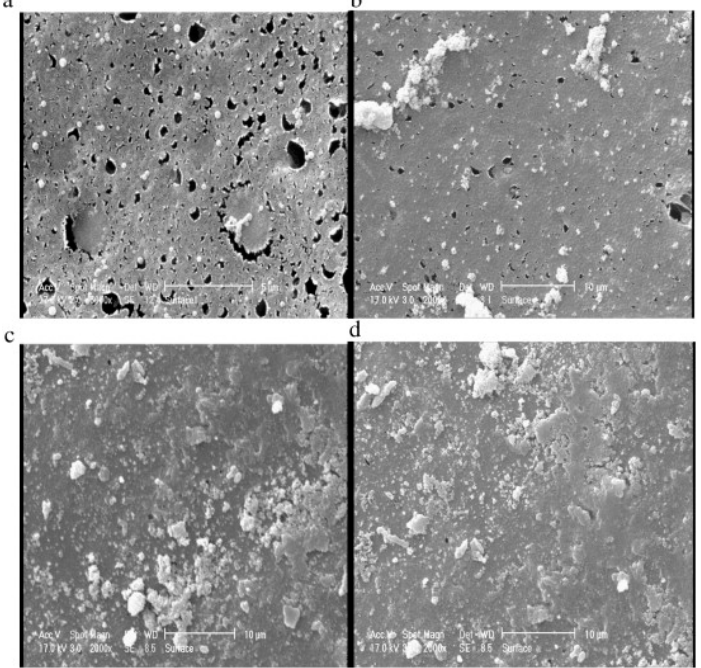
Figure 15. Surface SEM images of neat and TiO 2 deposited PVDF/SPES membranes: ( a ) neat membrane; ( b ) 0.1 wt % TiO 2 ; ( c ) 0.5 wt % TiO 2 ; ( d ) 1 wt % TiO 2 [7] TiO 2 nanoparticles are distributed uniformly on the surface of membrane and pores are filled with the NPs. Reproduced with permission from